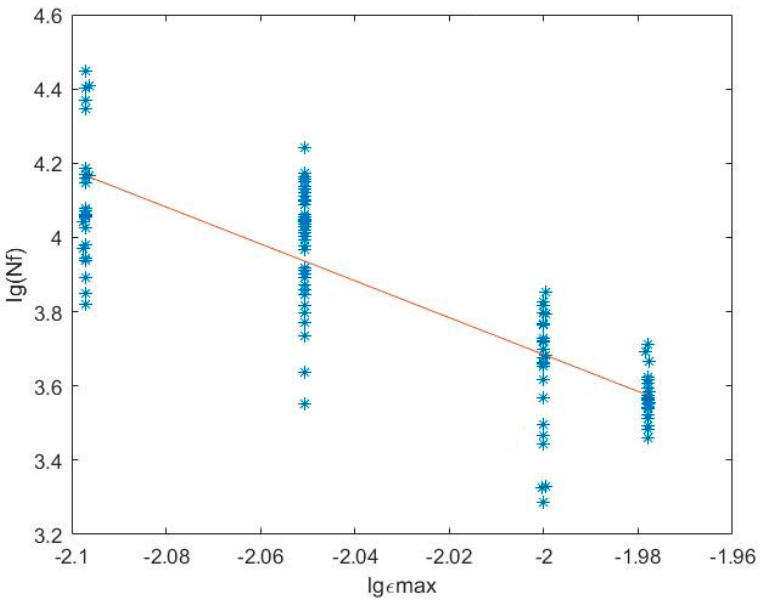
Figure 1. Damage parameter fitting when R = 0.05.